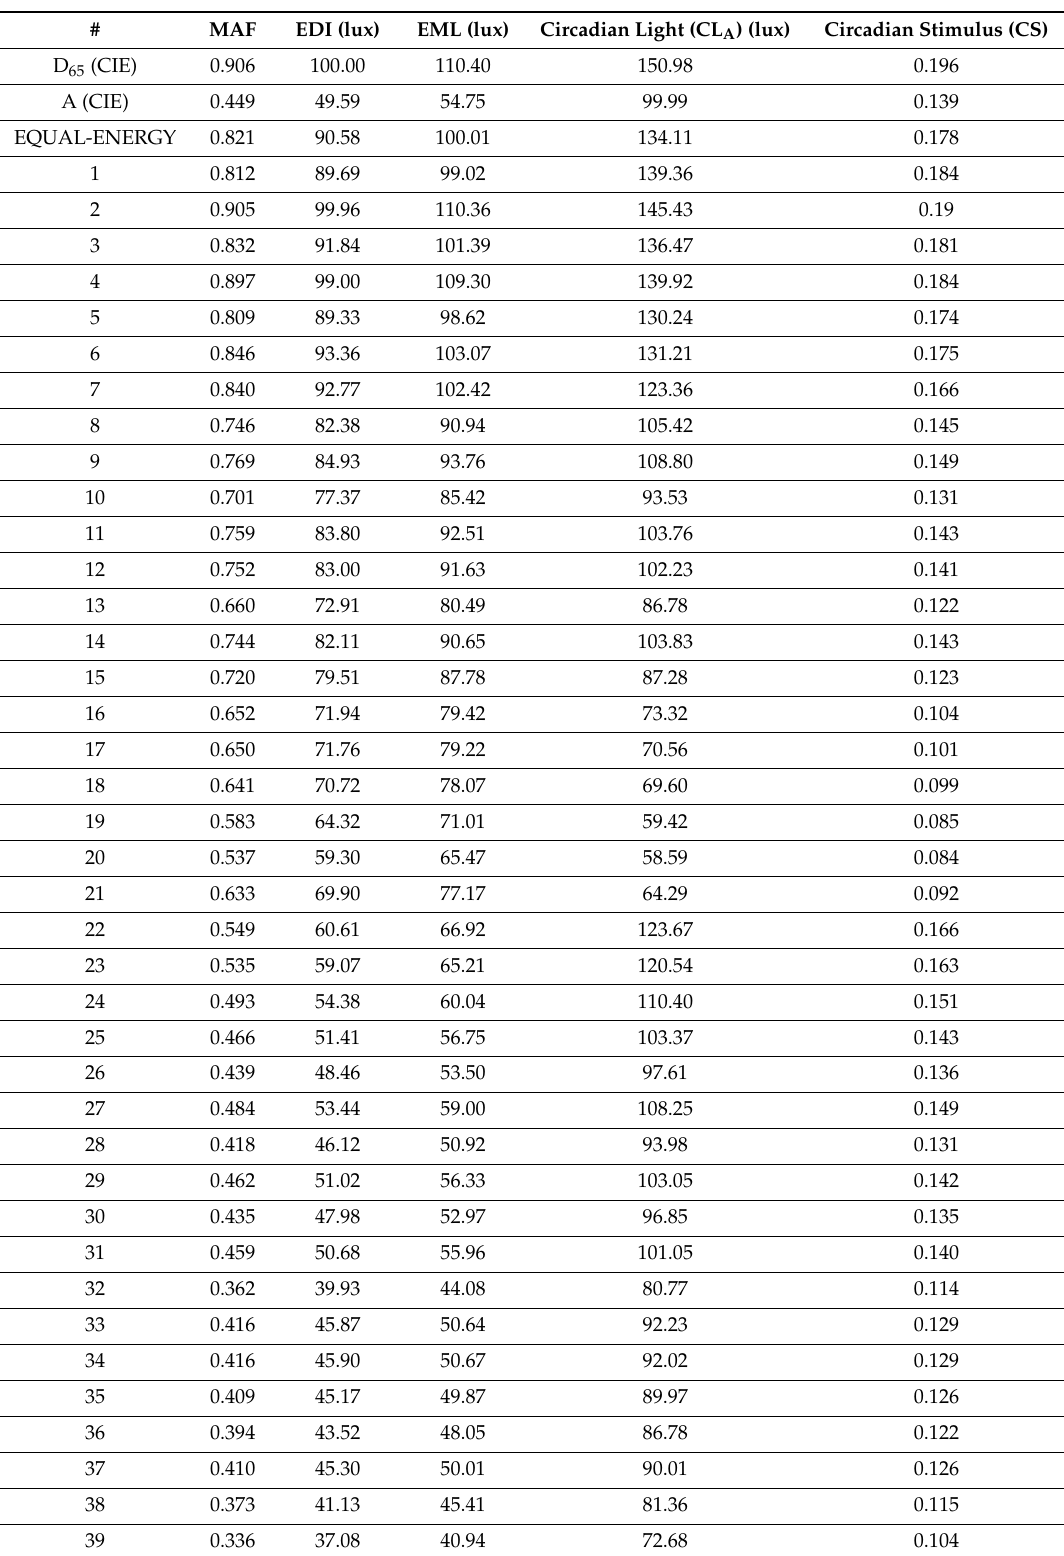
Table 2. Melanopic and circadian values calculated with the CIE (EDI), WELL (EML), and Rea metrics (CL A and